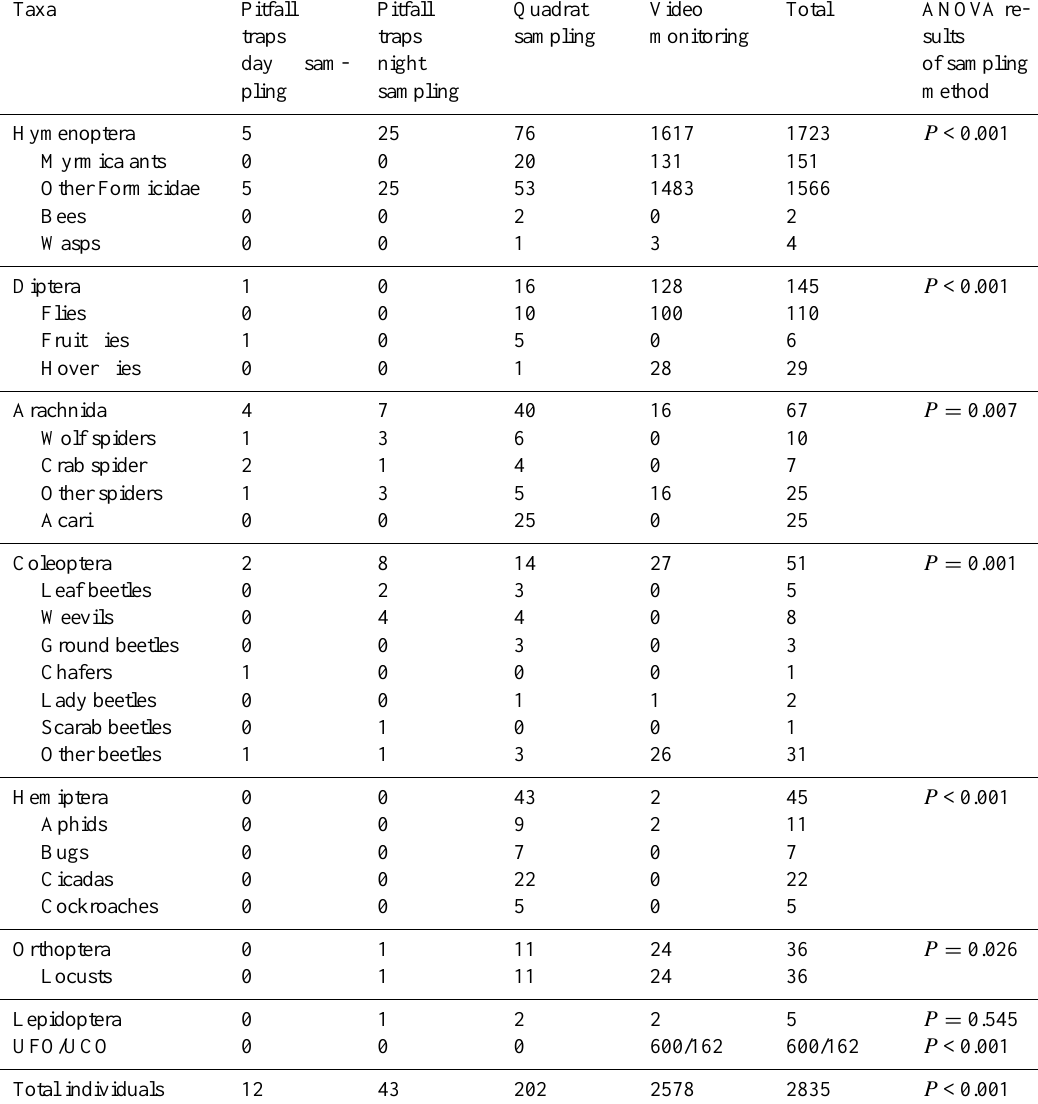
Table 1. Total numbers of recorded arthropod taxa for the four sampling methods across all sampling dates. UFO (undetermined flying organism) and UCO (undetermined crawling organism) are not identified individuals that were recorded only by video